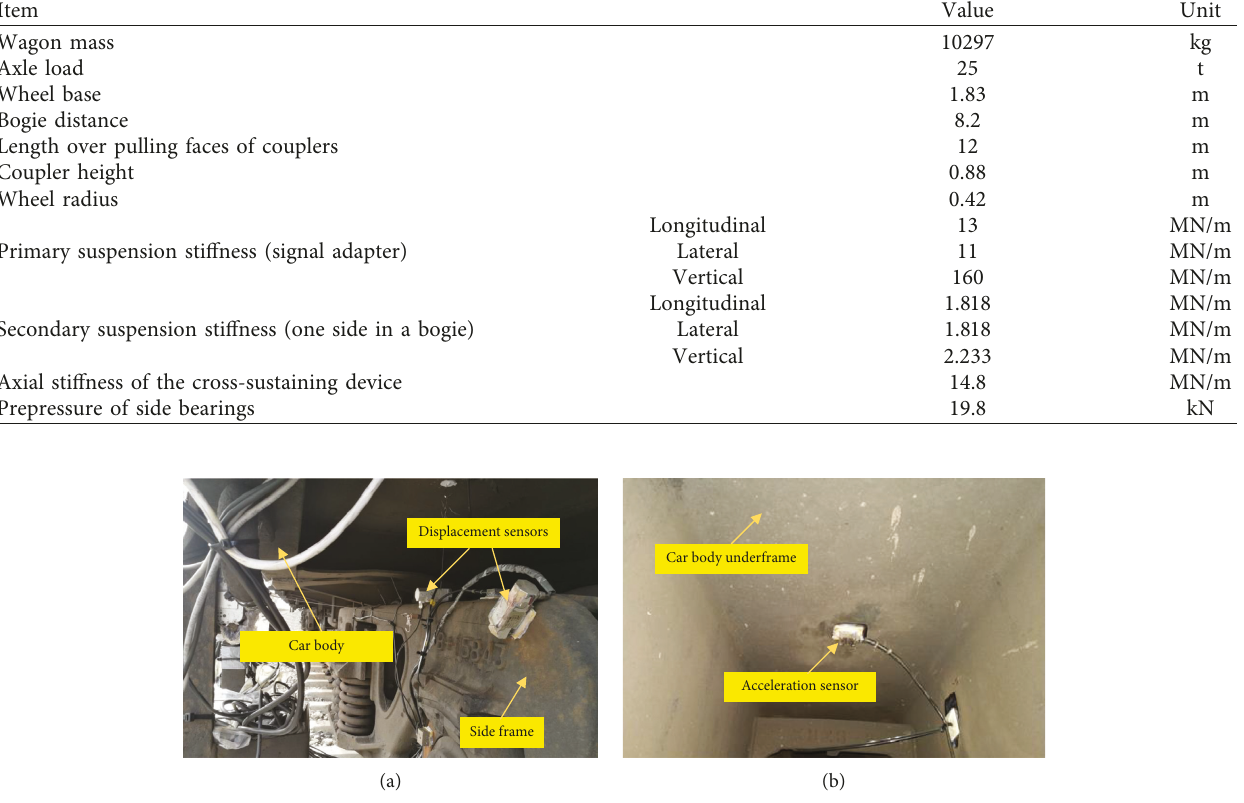
Figure 9: Instruments of the sensors: (a) displacement sensors on the side frame; (b) acceleration sensor on the car